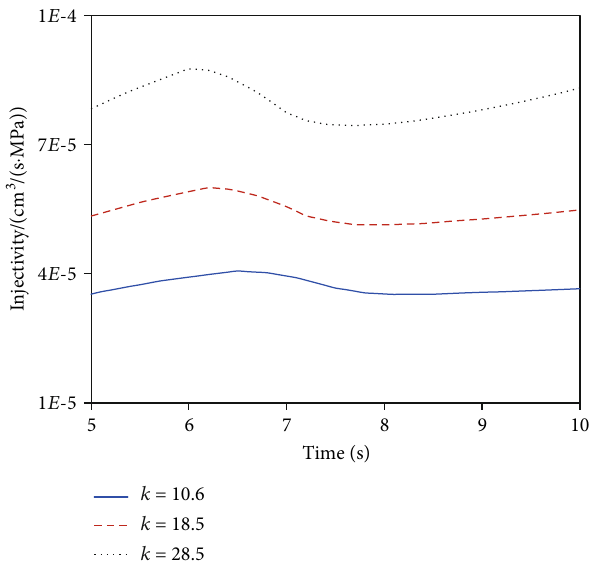
Figure 8: Injectivity change with time for di ff erent capillary tube